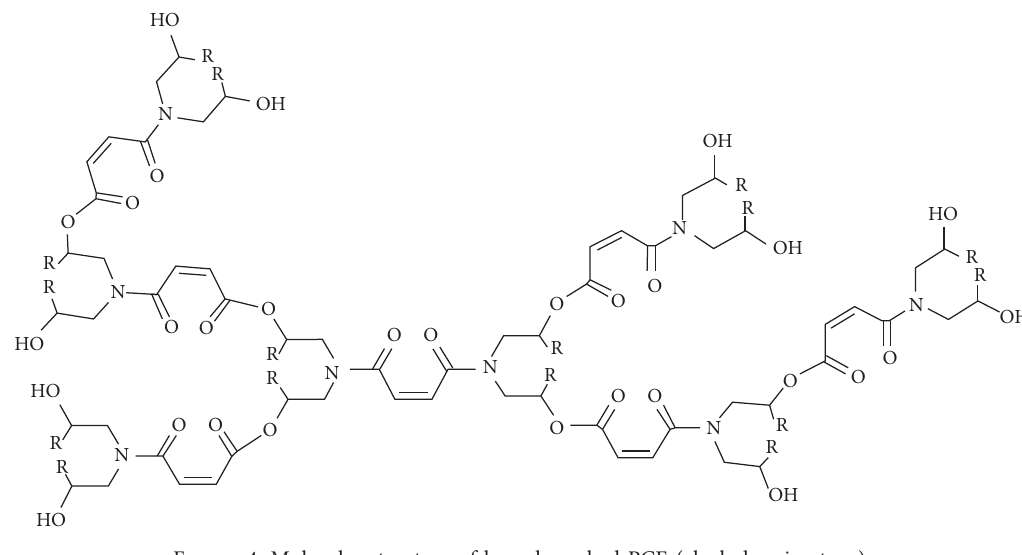
Figure 4: Molecular structure of hyperbranched PCE (alcohol amine type).